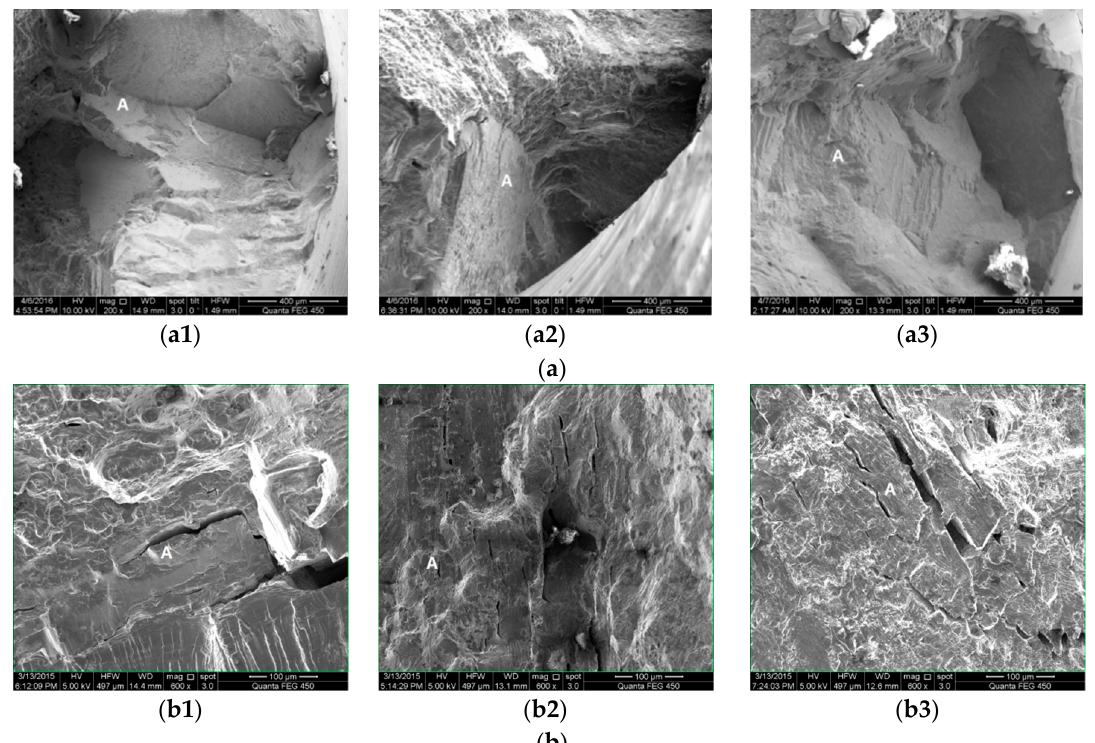
Figure 8. SEM fracture morphologies in fatigue crack initiation and propagation regions for AA6063 ‐ T4 and AA7475 ‐ T7351 in the different media. ( a ) AA6063 ‐ T4; ( a1 ) in the air case; ( a2 ) at 3.5 wt. % NaCl solution; ( a3 ) at 5.0 wt. % NaCl solution; ( b ) AA7475 ‐ T7351; ( b1 ) air, σ = 100 MPa; ( b2 ) 3.5 wt. %, σ = 80 MPa; ( b3 ) 5.0 wt. %, σ = 54.6